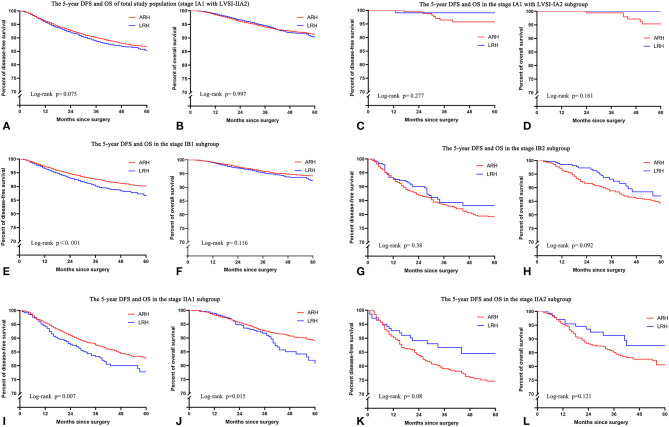
The unadjusted Kaplan-Meier survival curves of the entire cohort and different stages. (A,B) Stage IA1 with LVSI-IIA2, (C,D) stage IA1 with LVSI-IA2, (E,F) stage IB1, (G,H) stage IB2, (I,J) stage IIA1, (K,L) stage IIA2.